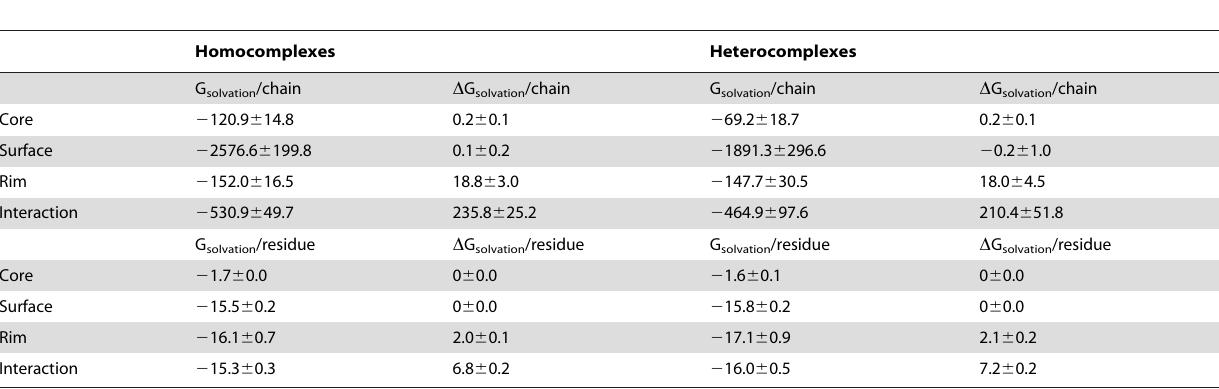
Table 2. G solvation and D G solvation per chain and per residue in the different parts of the protein structure.